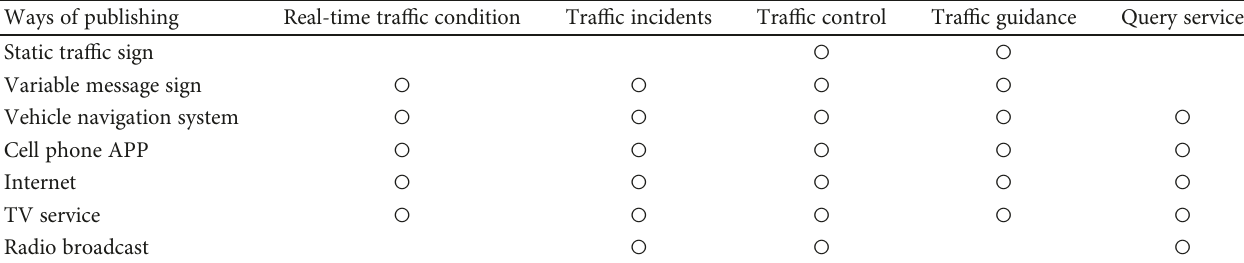
Table 1: Ways and types of information publishing.